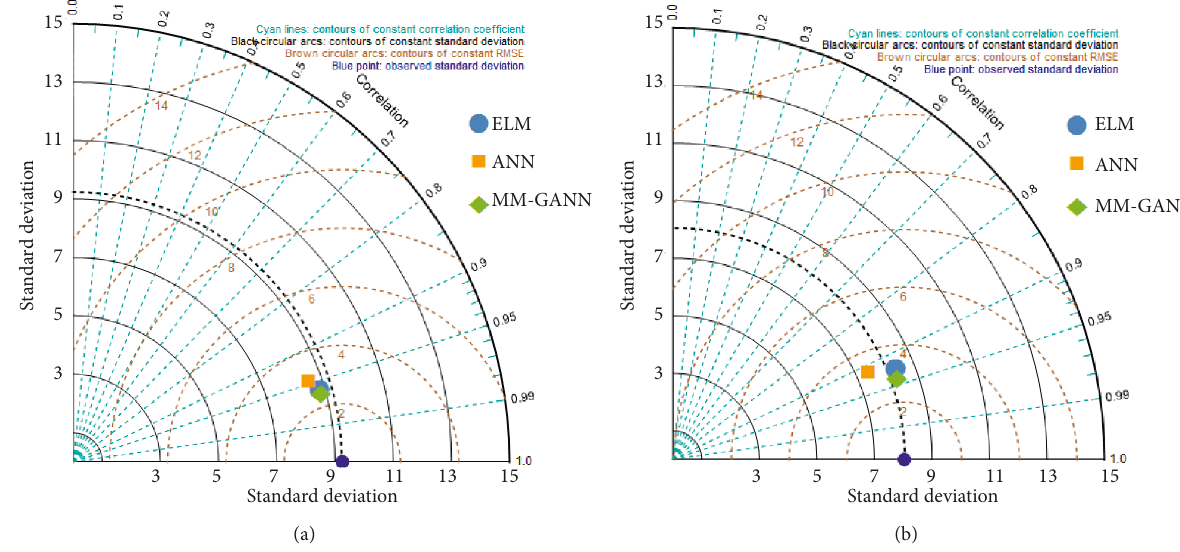
Figure 11: Taylor diagrams of the models at the training (a) and testing (b)